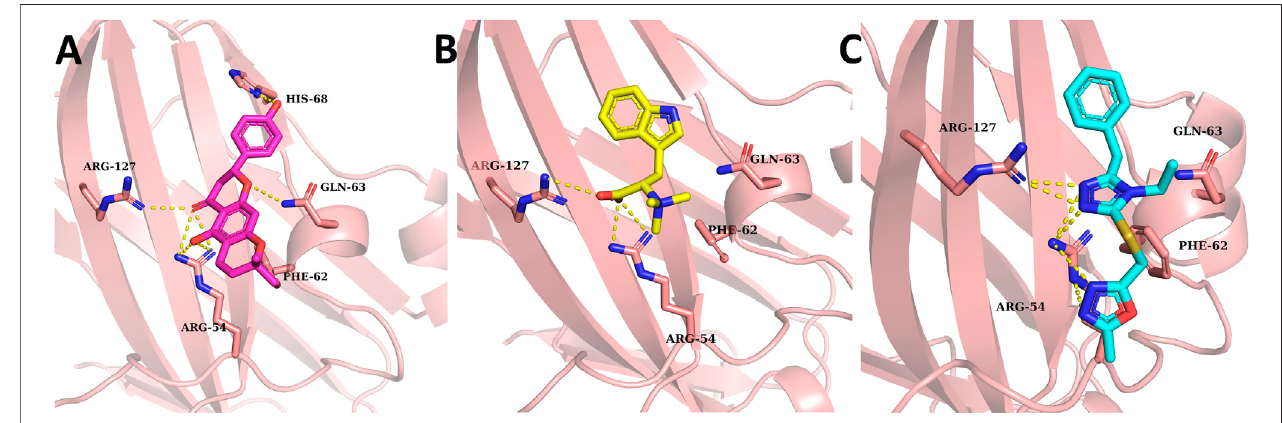
FIGURE 3 | Binding conformation and hydrogen binding residues of the top three compounds at the active site of VISTA (light pink). (A) 14187087 (dark pink), (B) 3861164 (yellow), and (C) 6494266 (cyan). Meanwhile, hydrogen bonding between residues is represented by yellow-colored dotted lines.